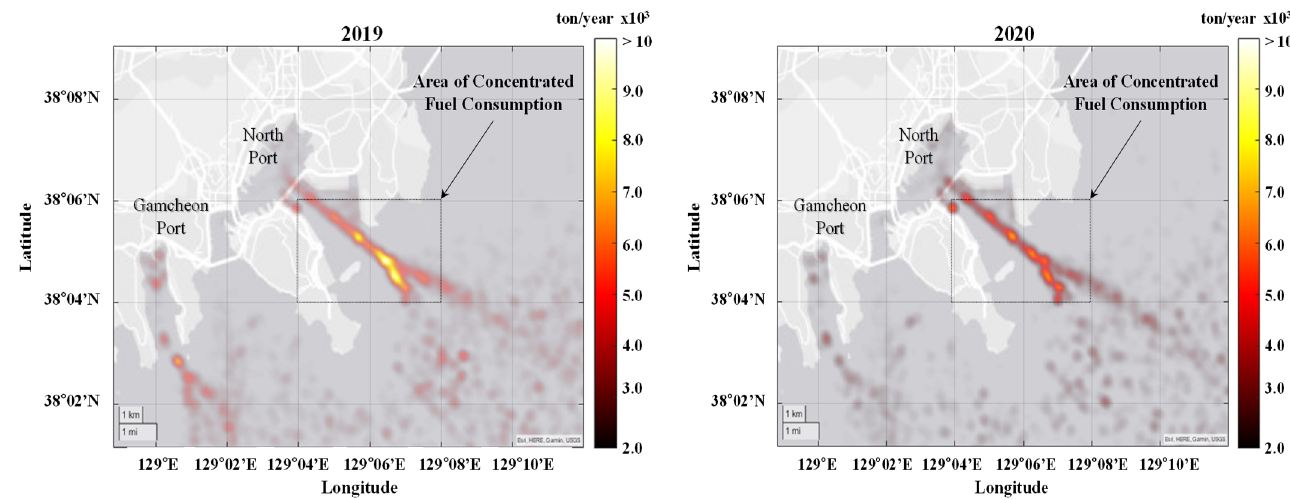
Table 6. Fuel consumption of ships underway using the engine in BP in 2019 and 2020.